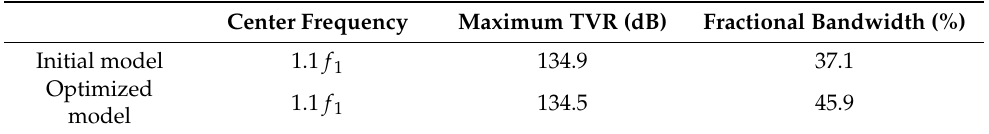
Figure 8. Comparison of the TVR spectra of the initial and optimized cymbal arrays. Table 3. Quantitative comparison of the acoustic characteristics of the initial and optimized cymbal arrays.